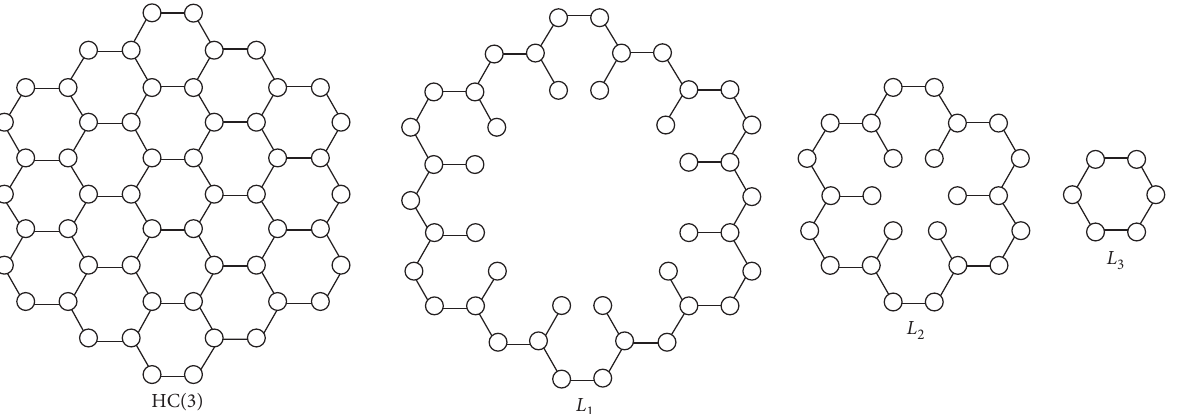
Figure 3: Hexagonal cluster graphs HC ( 3 ) with their layers L